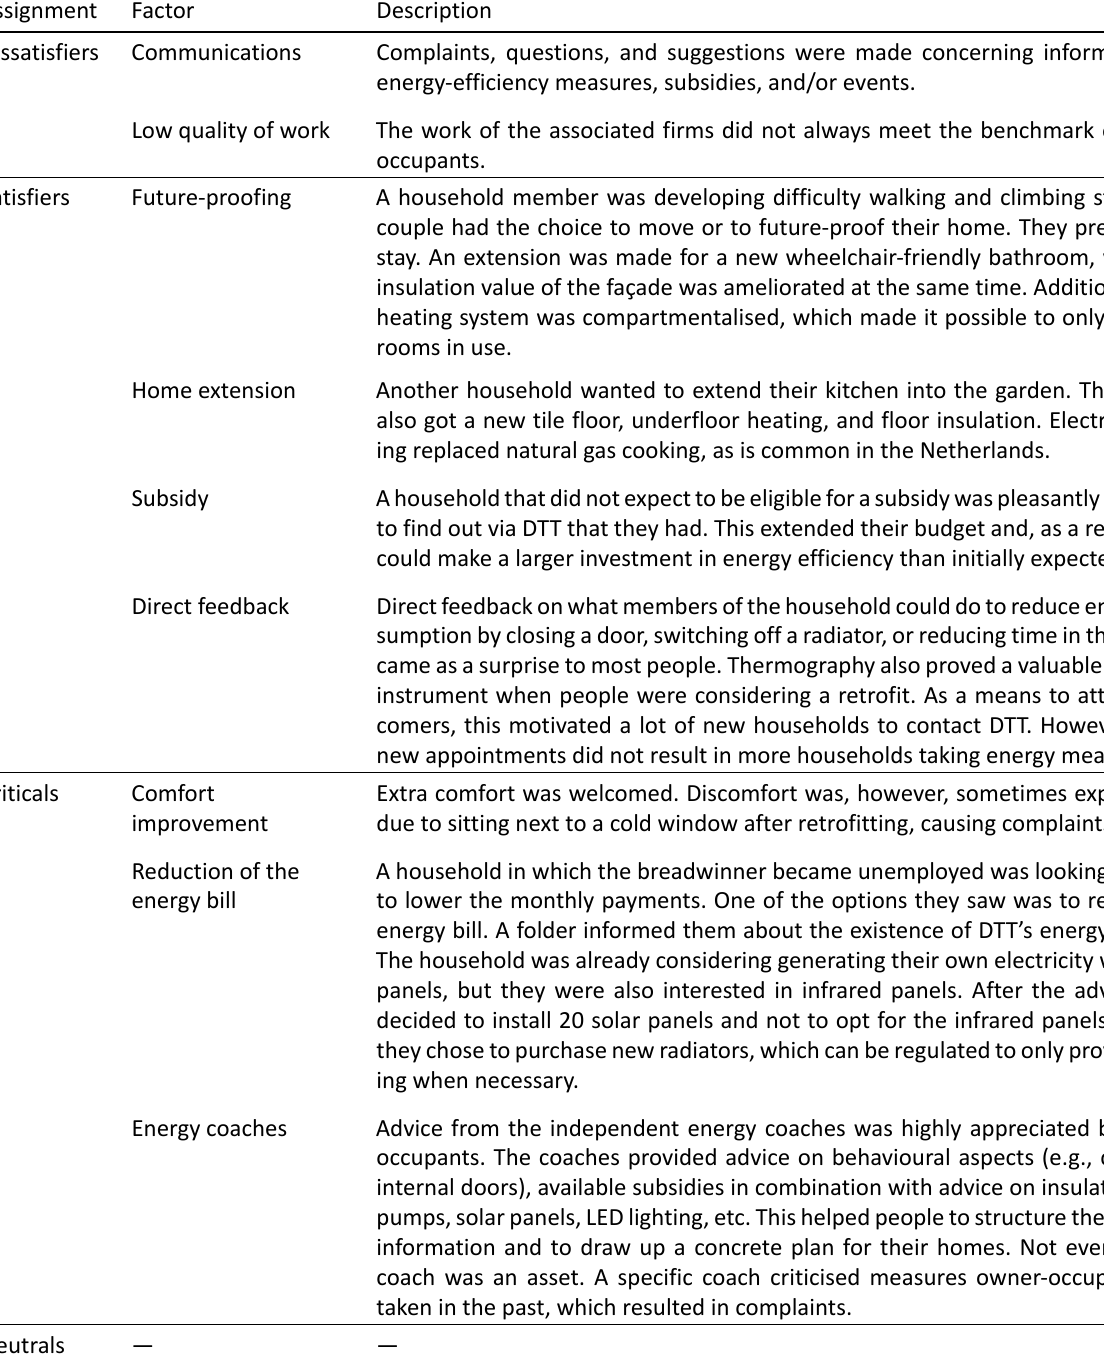
Table 3. Dissatisfiers, satisfiers, criticals, and neutrals in the perception of owner‐occupants involved in DTT. Category